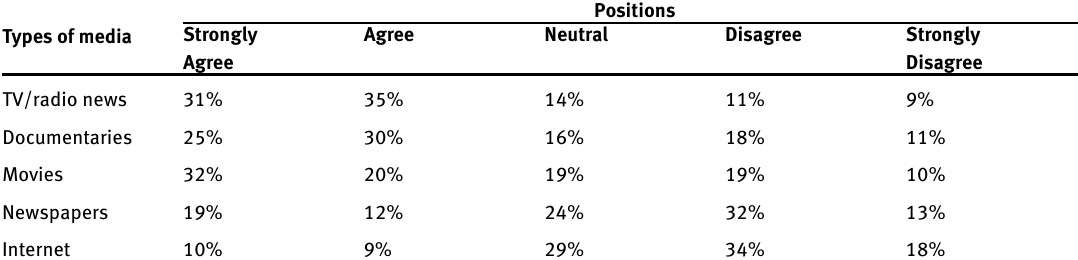
Table 5. Position towards language use in